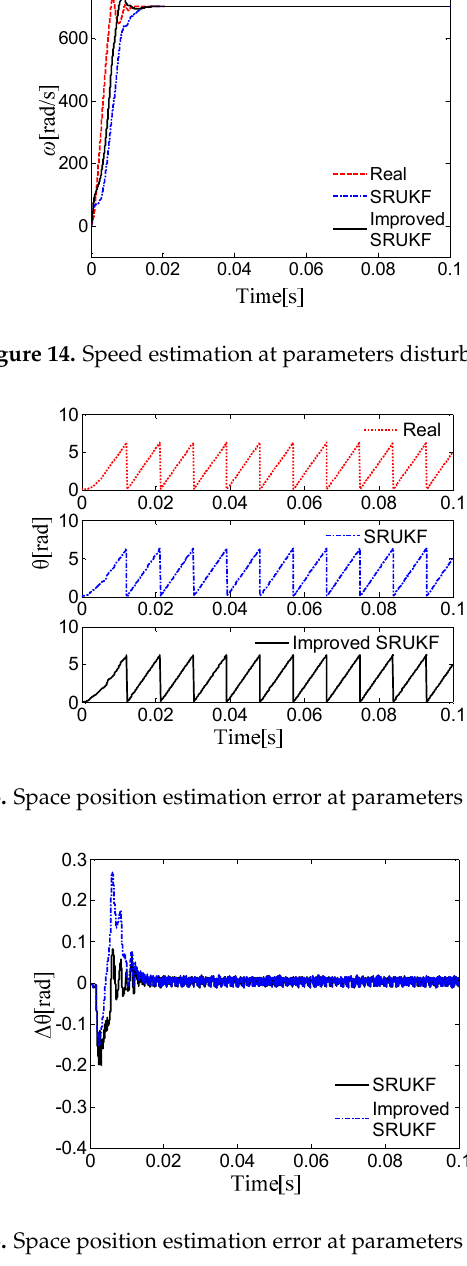
Figure 13. Space position estimation error at load disturbance. Energies 2016 , 9, 489